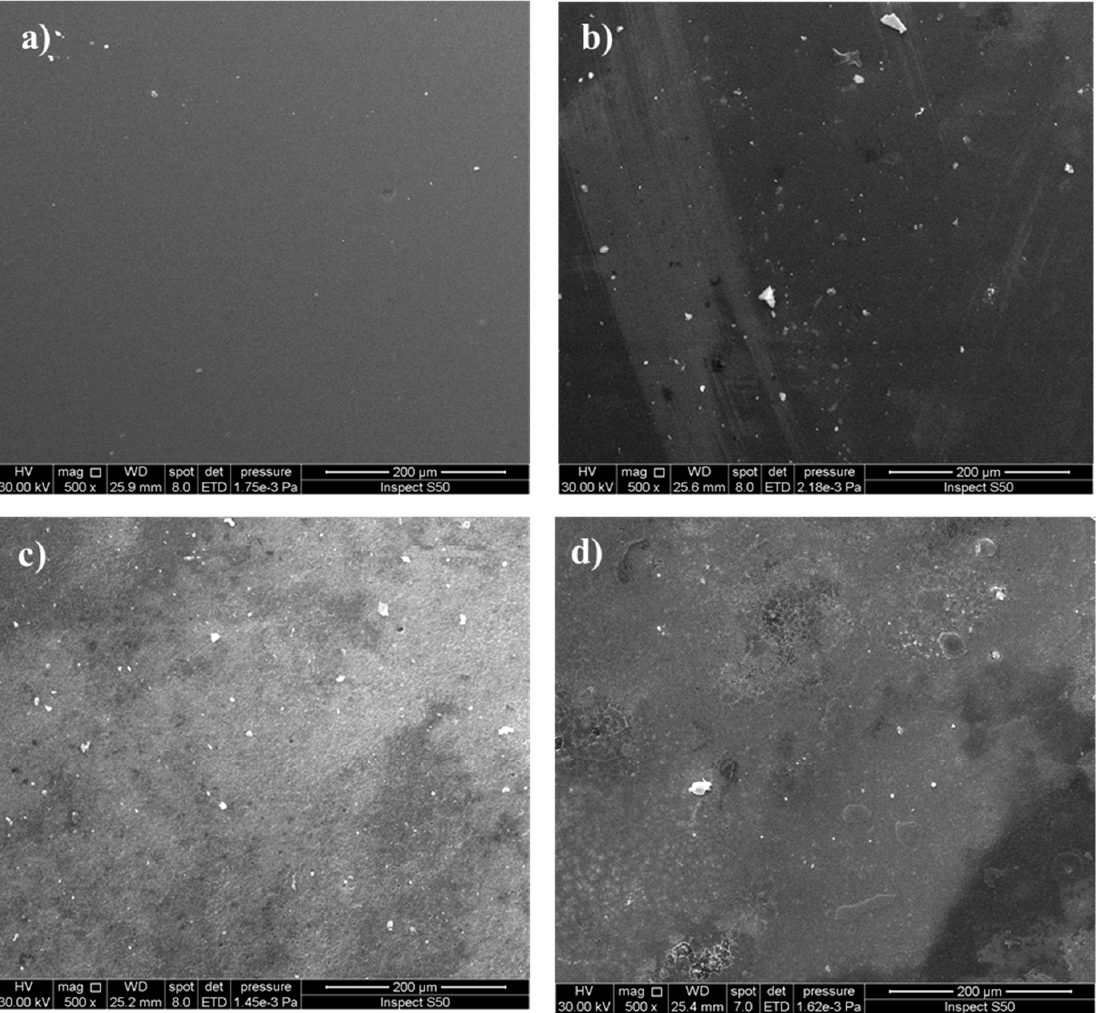
Figure 13. SEM images after irradiation of doped PVC with ( a ) PVC-ed/p-OH , ( b ) PVC-ed/o-OMe , ( c ) PVC-ed/p-OMe , ( d ) PVC-ed/o-NO 2 . ( c ) PVC-ed/p-OMe , ( d ) PVC-ed/o-NO 2